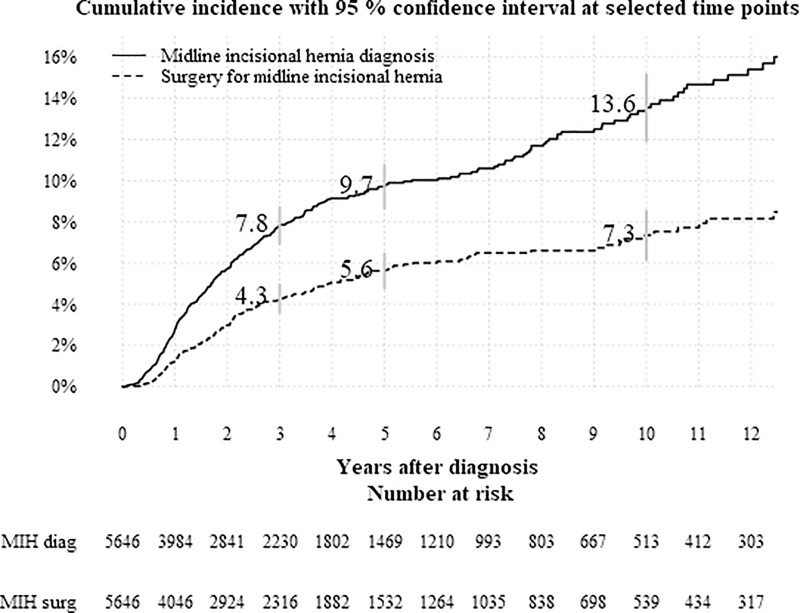
Cumulative incidence with 95% confidence interval at selected time points.The cumulative proportion of patients diagnosed with and operated for midline incisional hernia, respectively. Grey bars represent 95% CI at three, five and ten years.